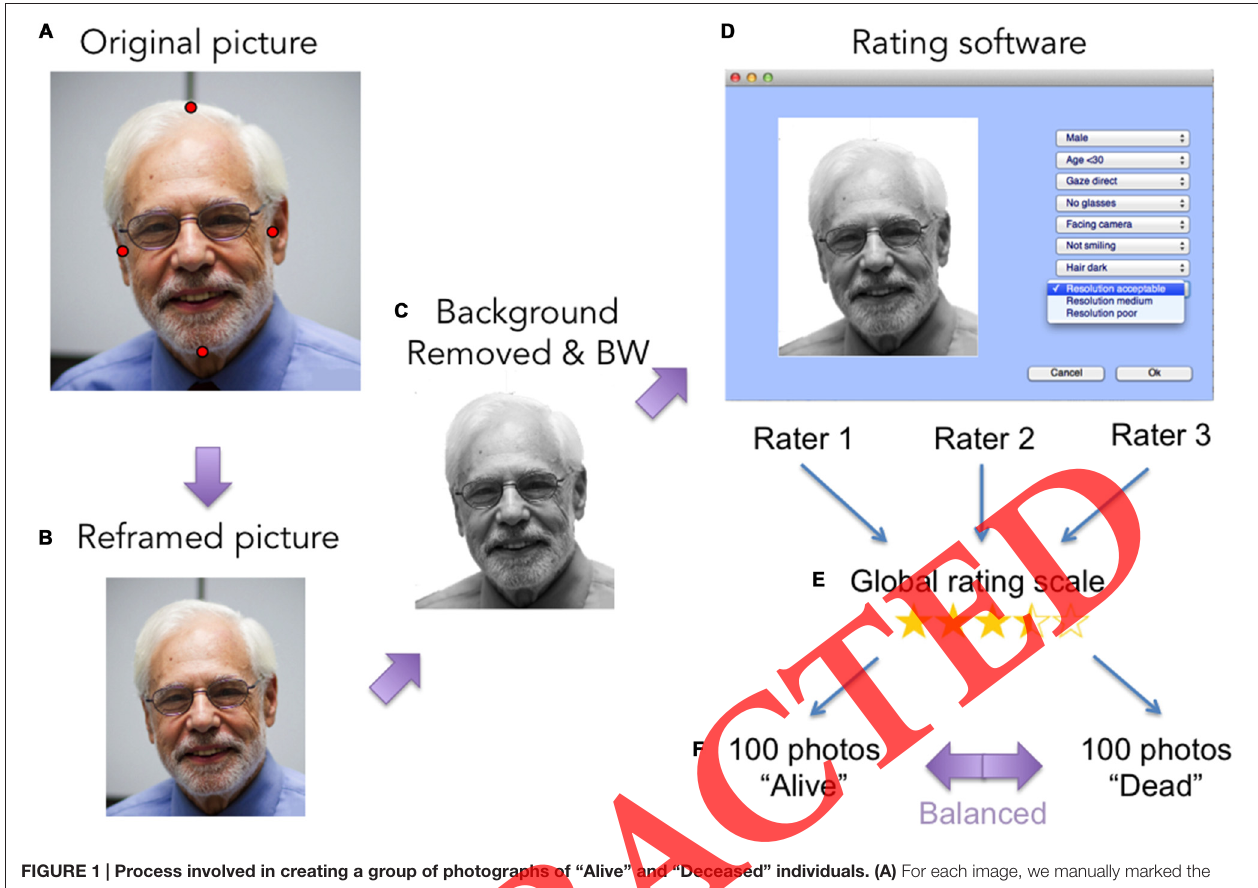
FIGURE 1 | Process involved in creating a group of photographs of “Alive” and “Deceased” individuals. (A) For each image, we manually marked the position of the ears, the chin and the top of the head. (B) The picture was then reframed based on these four points and interpolated to 120 × 80 pixels. (C) The image background was then removed using Photoshop, converted to gray scale and normalized. (D) Three judges independently rated all of the images on eight characteristics. (E) The ratings were combined to provide a global rating scale for each image. (F) A computer program generated two sets of images that were maximally similar in terms of the characteristics selected in (D)